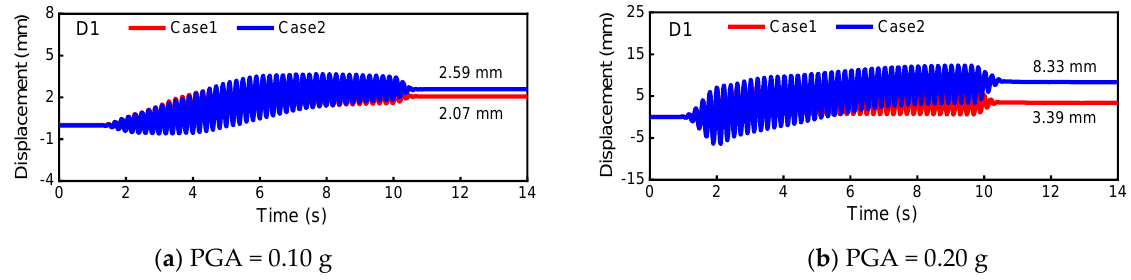
Figure 11. Lateral displacement of the bridge superstructure.